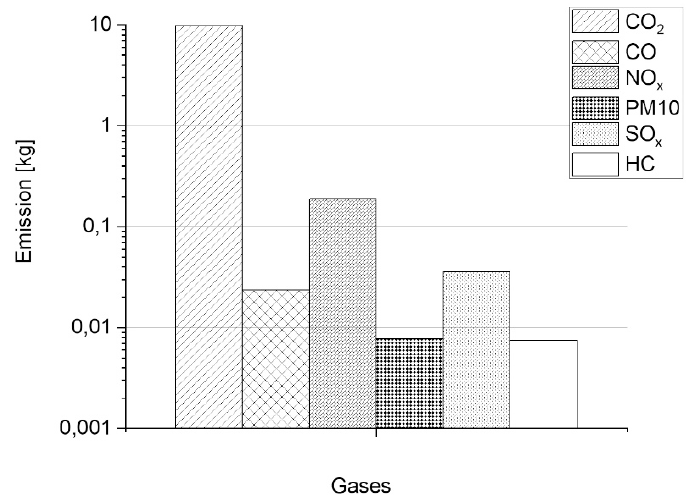
Figure 10. Graph of exhaust emissions of a diesel engine transmitting power of 7 kW to the main shaft during one hour [37].